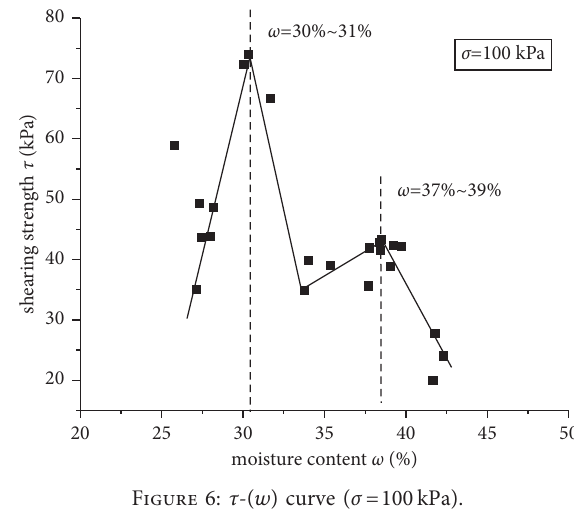
Figure 6: τ -( w ) curve ( σ � 100kPa).